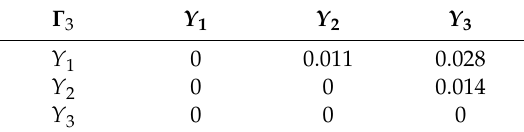
Table 9. The rejoice matrix Γ 3 .